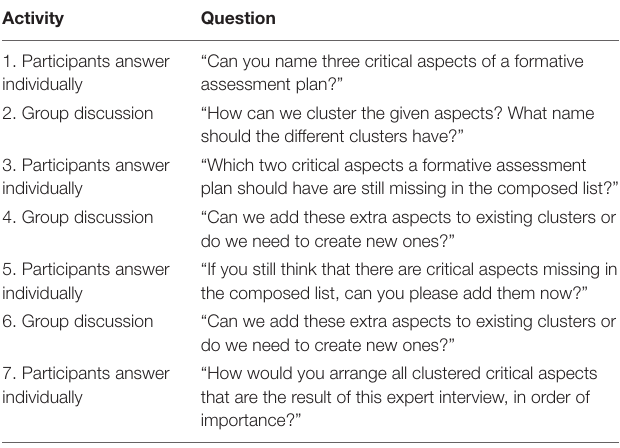
TABLE 2 | Activities and questions expert interviews. TABLE 3 | Participants group